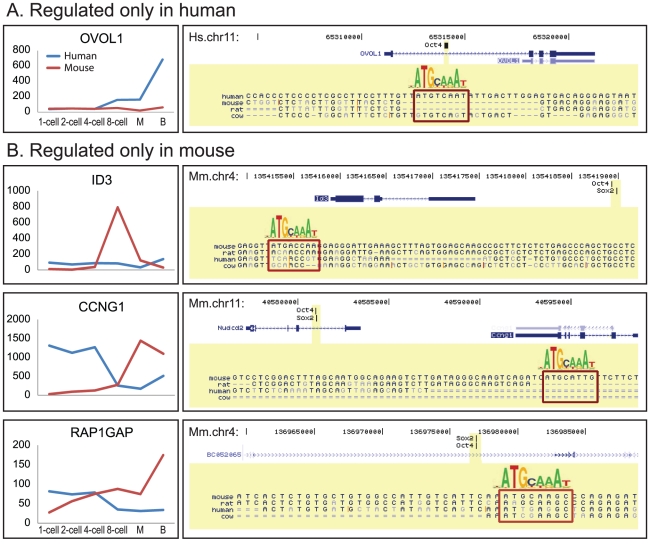
Examples of model-inferred species-specific target genes of Oct4 in humans (A) and mice (B).Oct4 is zygotically expressed (4–8 cells), and it is strongly increased at the late stages of pre-implantation development, including morula (M) and blastocyst (B). The target genes' expression is zygotically activated in a species-specific manner (Left panel). The species-specific binding of Oct4 to target genes is observed in ChIP-seq experiments (TFBS track, right panel). The genomic sequences of the Oct4 binding regions are shown in yellow, with Oct4 binding motifs shown in red boxes.